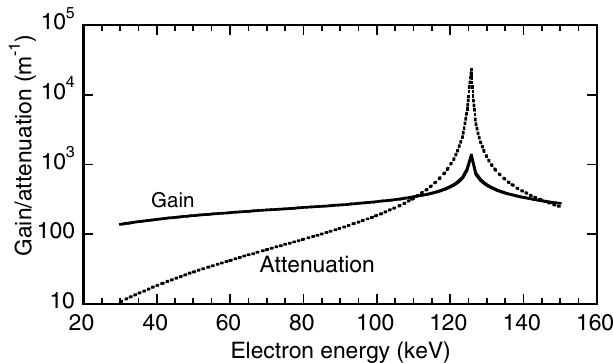
FIG. 3. Gain and attenuation calculated for the Dartmouth SP- FEL